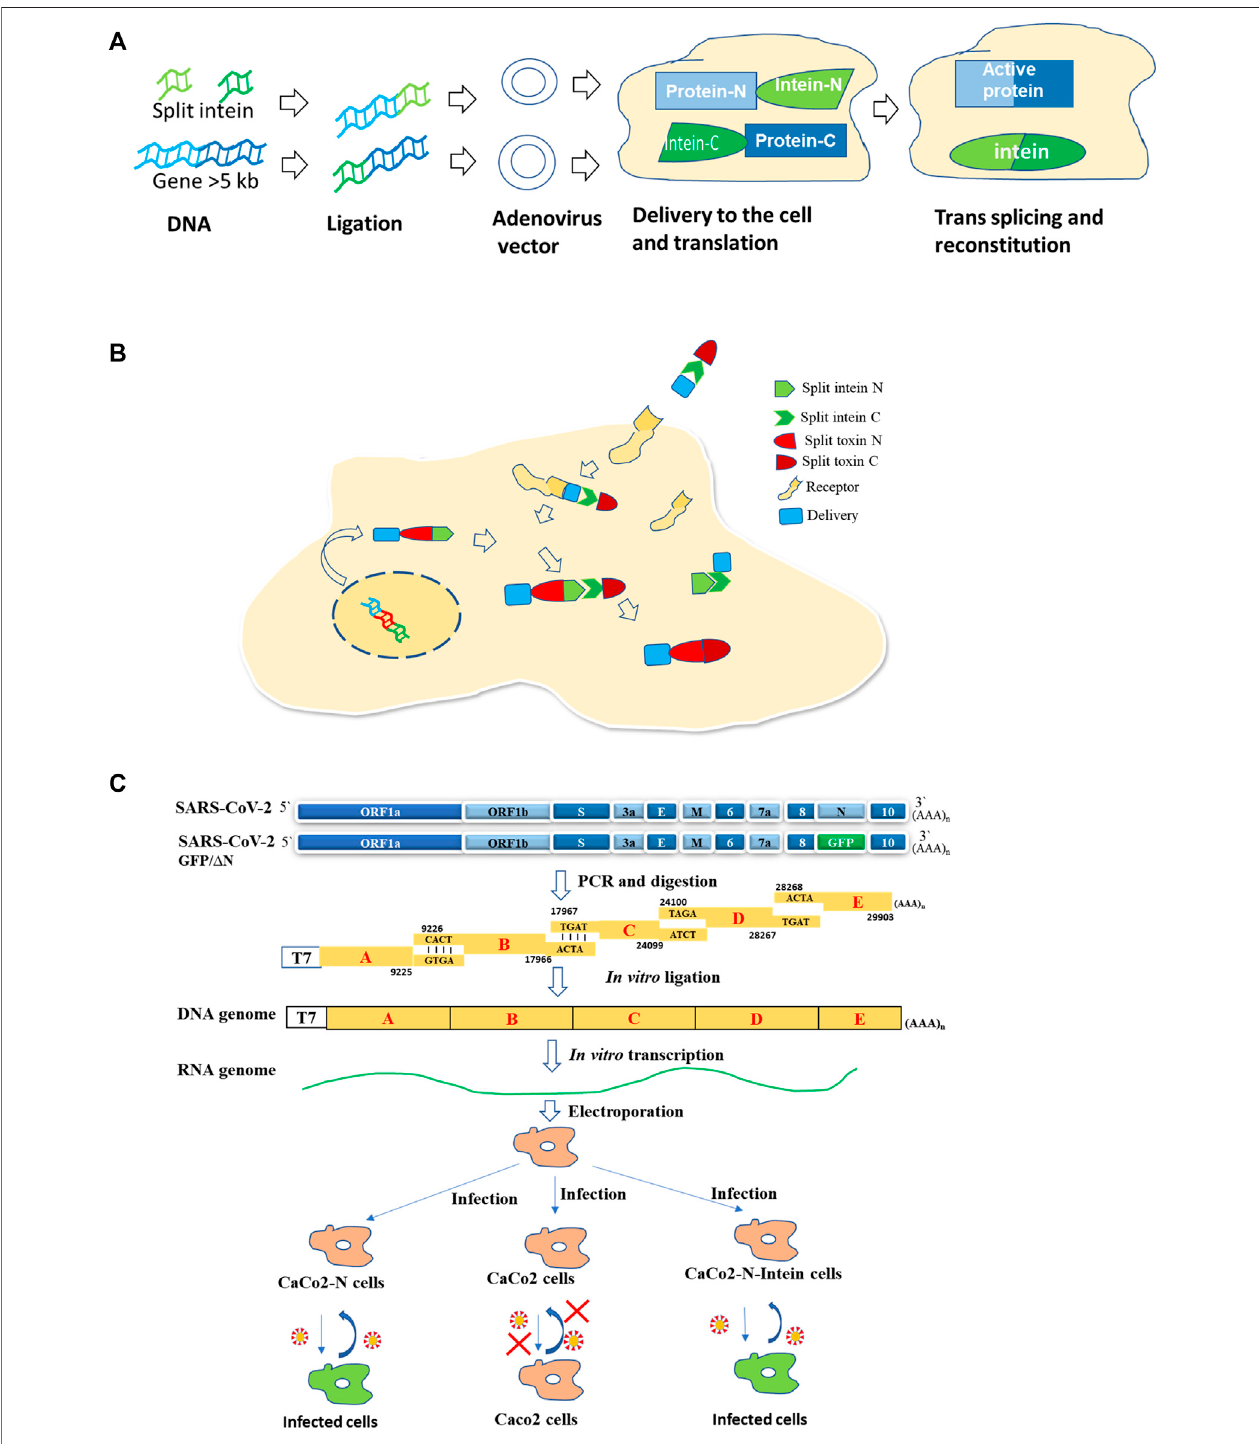
FIGURE 2 | Use of split intein in therapy and pathogenesis studies. (A) Large gene delivery in gene therapy (Tornabene et al., 2019; Lim et al., 2020). (B) Intein mediatedtoxin reconstitution insidethe cellsforselectivecellkillingintumor therapy (Purde et al.,2020). (C) DevelopmentofaBSL2cellculturemodel forSARS-COV-2 in CaCo2 cells (Ju et al.,